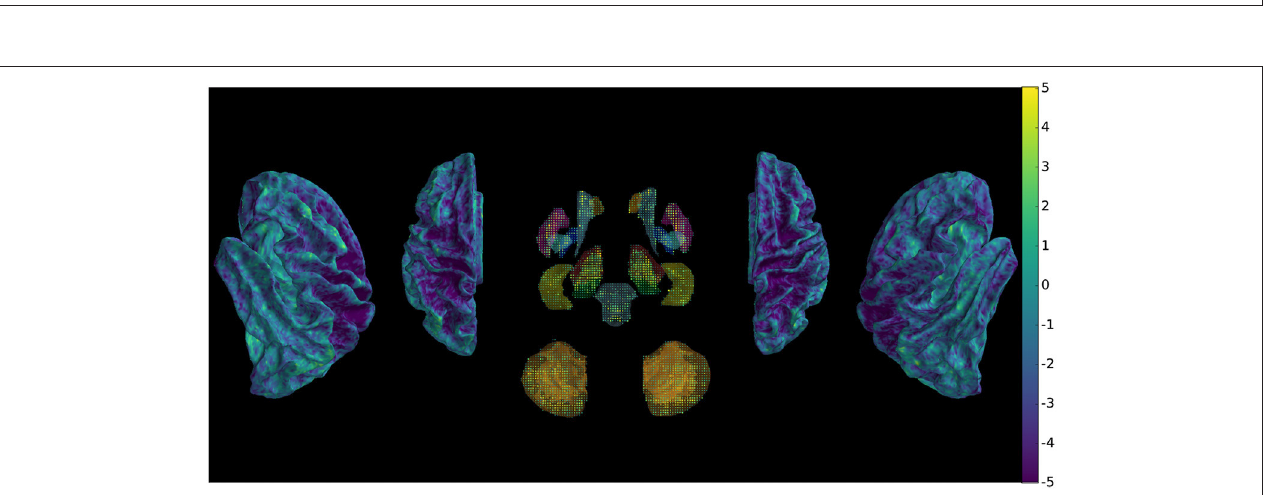
Frontiers in Neuroscience |